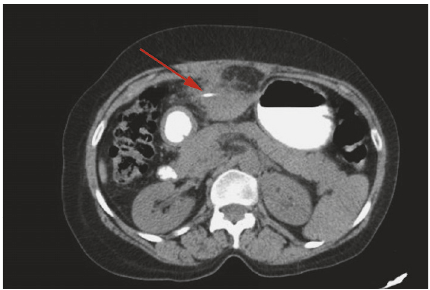
Figure 2: Axial view CT scan of the abdomen and pelvis showing a radiopaque FB in the liver (red